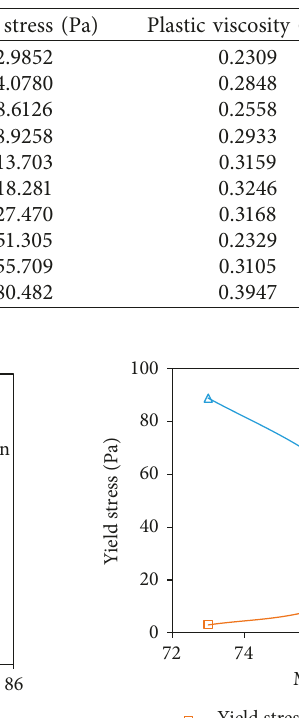
Table 3: Bingham rheological model regression for each mass concentration.